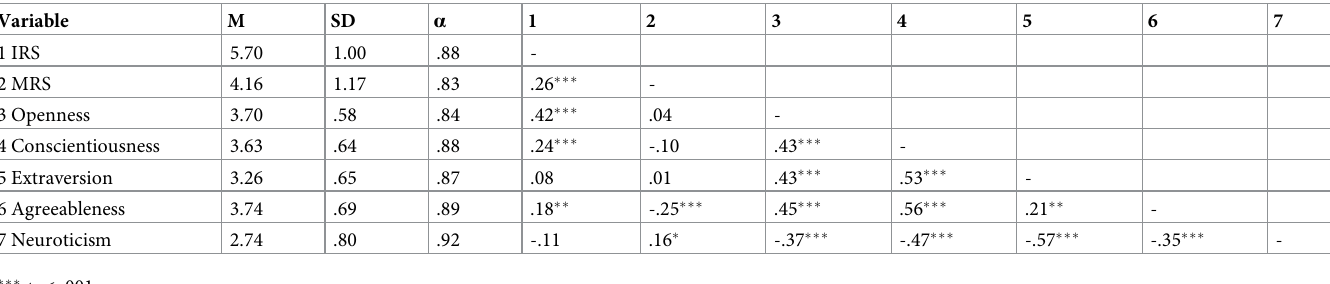
Table 1. Means, Standard deviations, Chronbach’s Alphas, and zero-order correlations (Study 1).